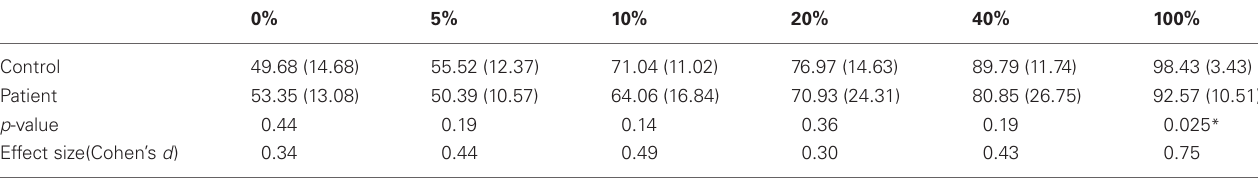
Table 3 | Accuracy for coherent motion detection at each coherence condition: group mean ( SD ).